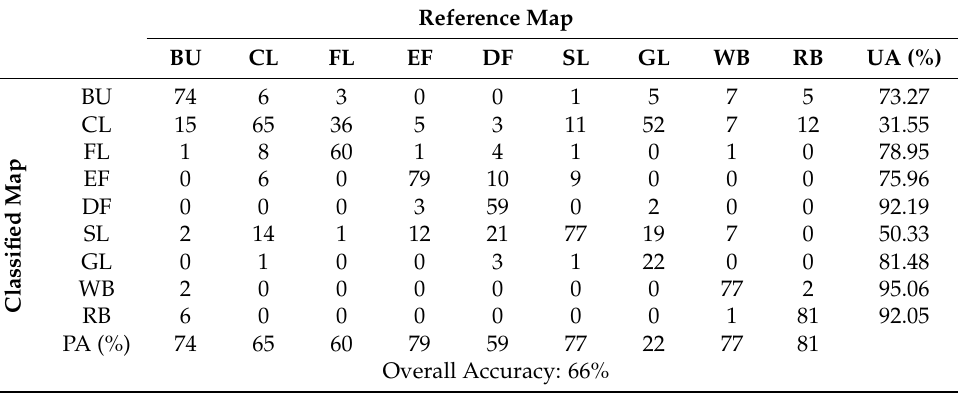
* Rounded off to the nearest integer. Table 6. Error matrix generated using the RF classifier for the stratified systematic sampling (SSS) method with dataset D-2 and 100 validation pixels per class, during a single trial. The class-level performance in terms of producer accuracy (PA) and user accuracy (UA) is depicted under PA row and UA column (BU—Built-Up, CL—Cropland, FL—Fallow Land, EF—Evergreen Forest, DF— Deciduous Forest, SL—Shrubland, GL—Grassland, WB—Water Body, RB—River